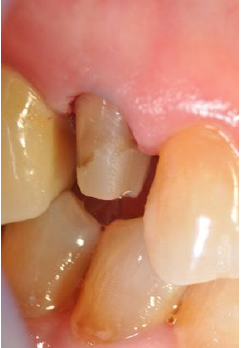
Figure 2. The abutment after preparation.